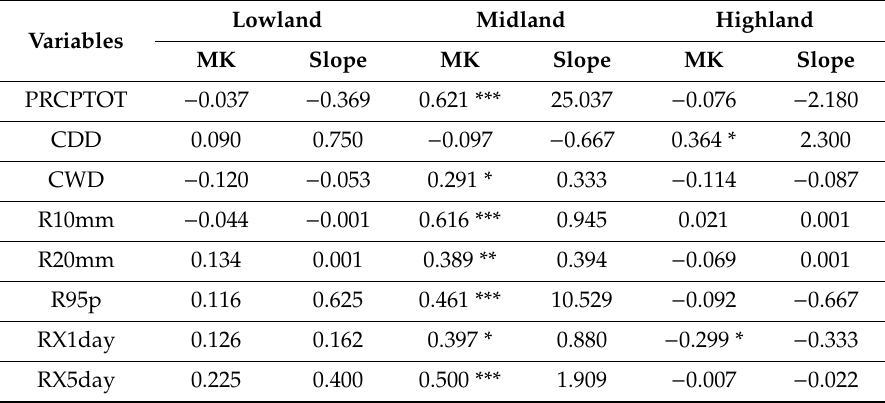
Table 2. Trends of precipitation indices by agro-ecological settings (1988–2017).